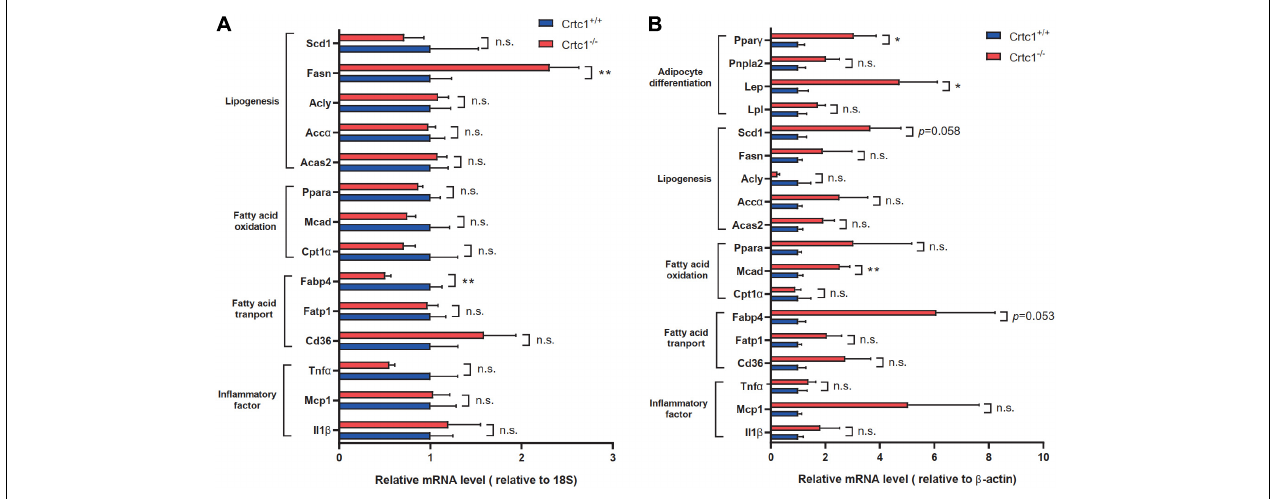
FIGURE 7 | Validation of lipid-metabolism-related genes. (A,B) Expression of key genes related to different lipid metabolism processes in liver (A) and eWAT (B) , measured by qRT-PCR. Data are mean ± SEM; * P < 0.05; ** P < 0.01 and n.s. indicates no significant difference between Crtc1 + / + and Crtc1 − / − groups. n =